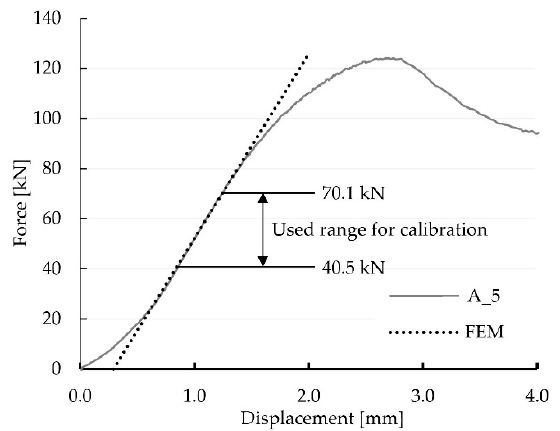
Figure 6. Experimentally, as well as numerically (FEM), determined load-displacement curves of specimen A_5. The FEM line was shifted to the right to facilitate comparability.